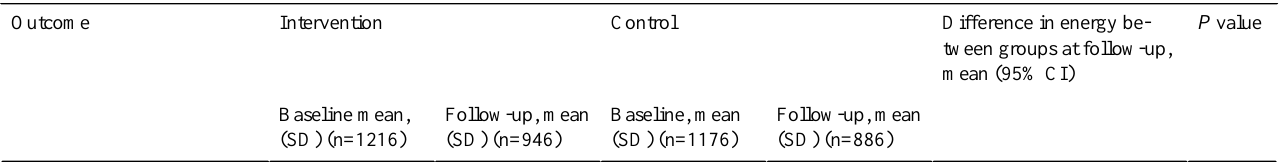
Table 2. Mean energy and percentage of energy from everyday and discretionary foods packed and consumed from student lunchboxes.